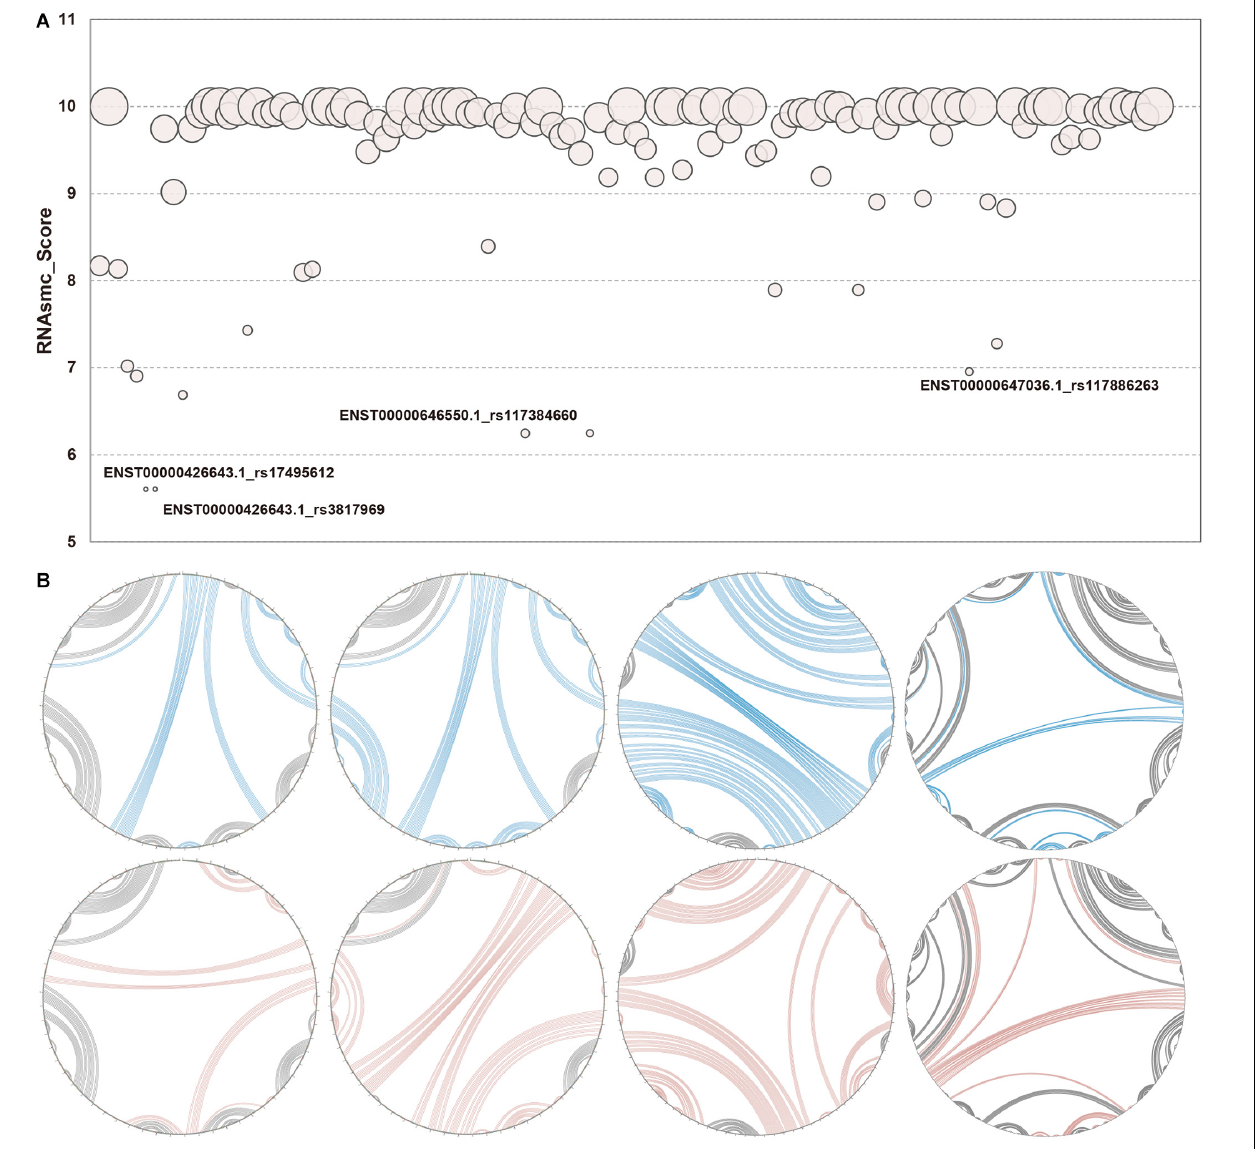
FIGURE 3 | Structural heterogeneity analysis of lncRNA transcripts altered by LD SNPs. (A) Quantification of WT and MT lncRNA transcripts. The x axis showed 115 items among LD SNPs, lncRNA transcripts, and lung diseases. The y axis represented RNAsmc scores. The size of each circle indicated the P value of the RS1. (B) Circular structural comparison of WT and MT lncRNA transcripts. The corresponding relationships between WT and MT lncRNA transcripts and LD SNPs. The lines in blue and red represented the corresponding regions of WT and MT lncRNA transcripts, respectively, altered by LD SNPs. The label under each circle indicated lncRNA transcript, SNP and alleles of SNP. e.g., G535A showed that 535 base G in ENST00000426643.1 change to A.